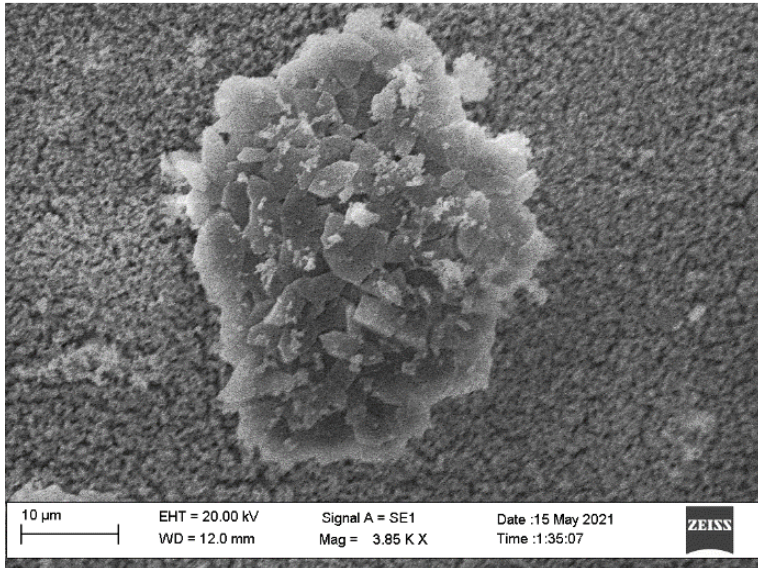
Figure 7. SEM image of PM on filters.